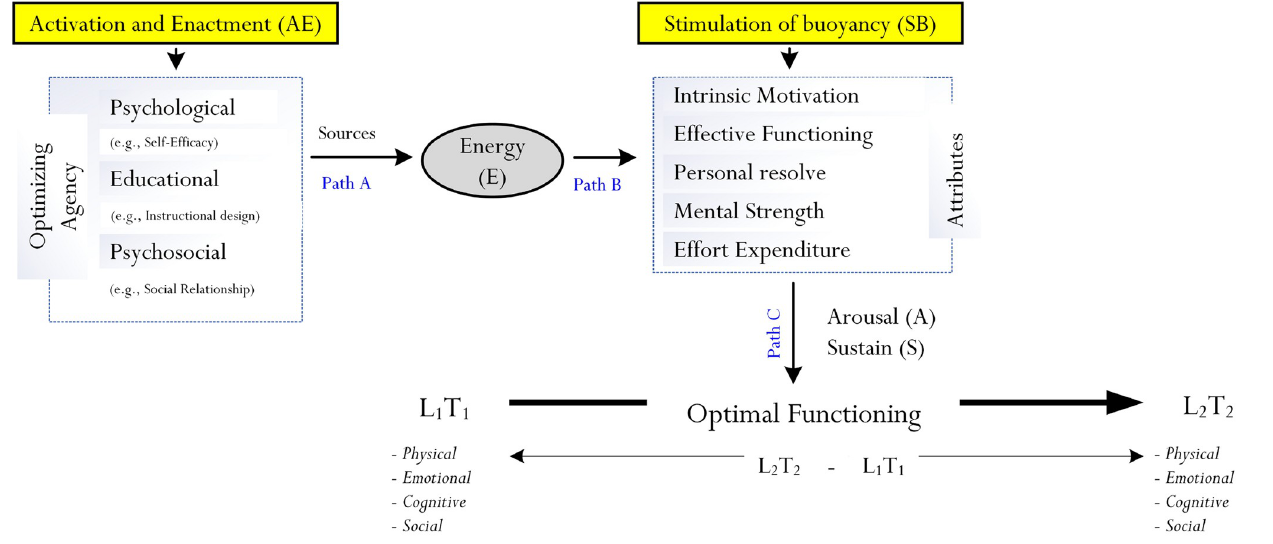
Fig 1. Proposed process of optimization. The process of optimization, as Phan, Ngu, and Yeung (2019) detailed in their recent publication, considers three fundamental aspects and, correspondingly, three pathways (i.e., Path A, Path B, and Path C): (i) the activation and enactment (denoted as ‘AE’) of optimizing agents, (ii) the instilment of a perceived feeling of energy, and (iii) the stimulation of buoyancy of different psychological attributes (e.g., intrinsic), which would arouse and sustain a state of functioning. L 1 = current best practice, L 2 = optimal best practice, T 1 = time 1, T2 = time 2. Source: Phan, H. P., Ngu, B. H., & Yeung, A. S. (2019). Optimization: In-depth examination and proposition. Frontiers in Psychology , 10(Article 1398), 1–16. doi:10.3389/fpsyg.2019.01398.